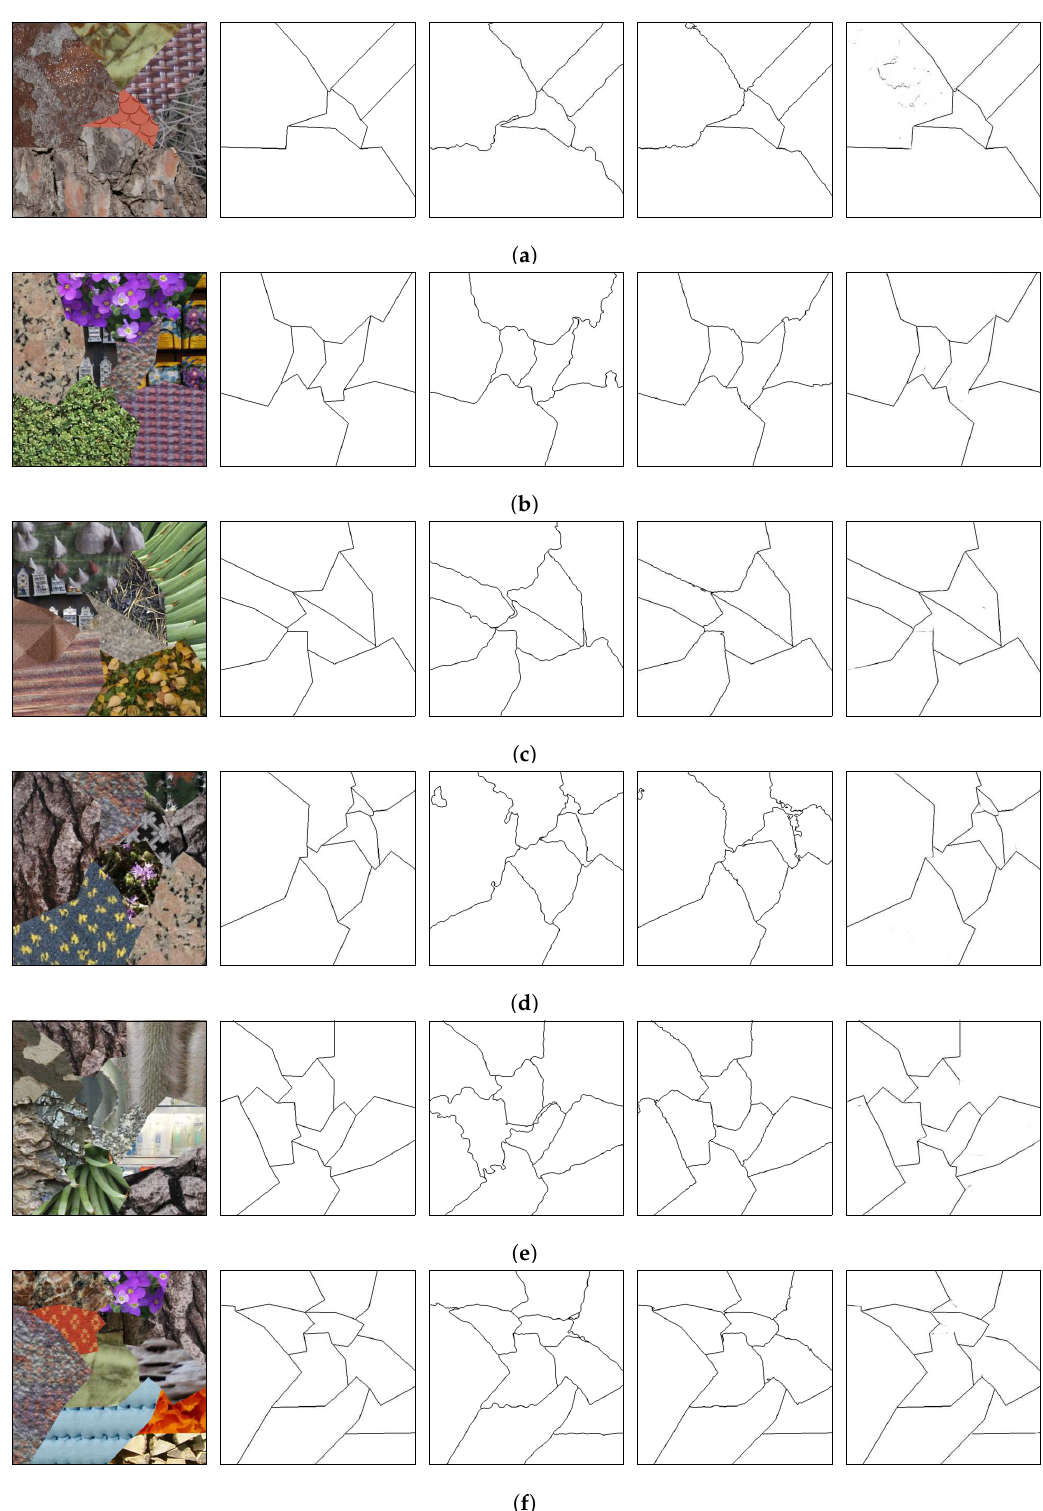
Figure 15. Comparison on the Prague Texture Dataset Generator and Benchmark [70]. From the first to the fifth column, respectively: original images; ground truths; edges produced by the network in [67]; edges produced by the network in [69]; edges produced in the presented method. Letters ( a – f ) present different benchmark textures mosaics and are used for referencing the images in the